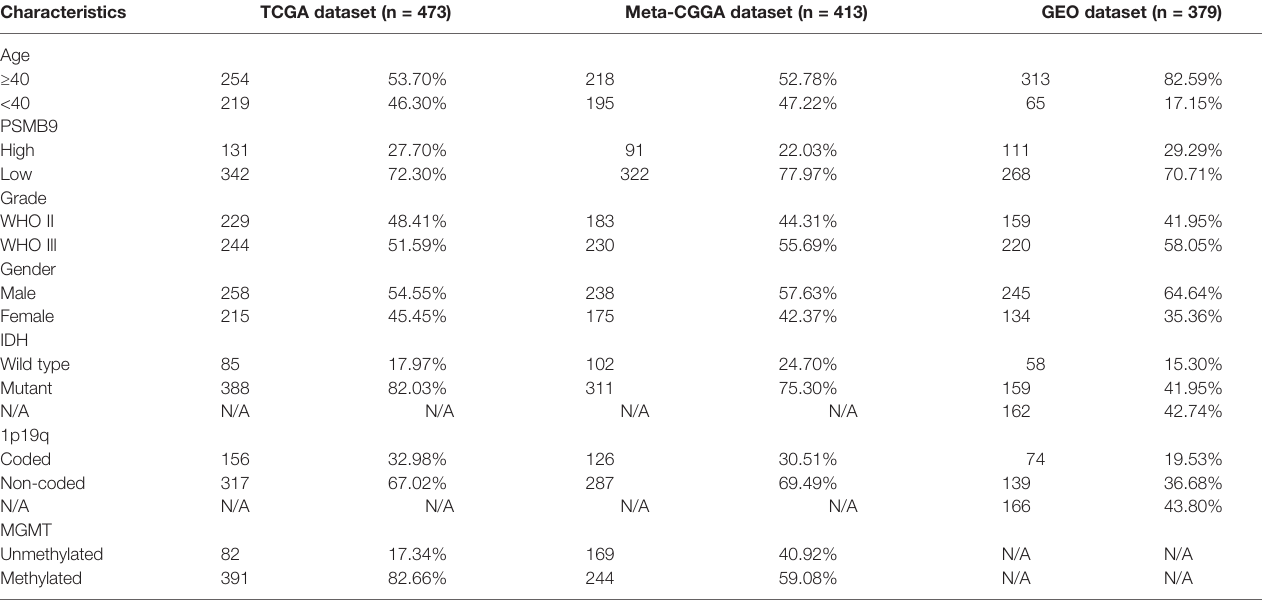
TABLE 1 | Summary of clinical information of LGG patients included in this study.